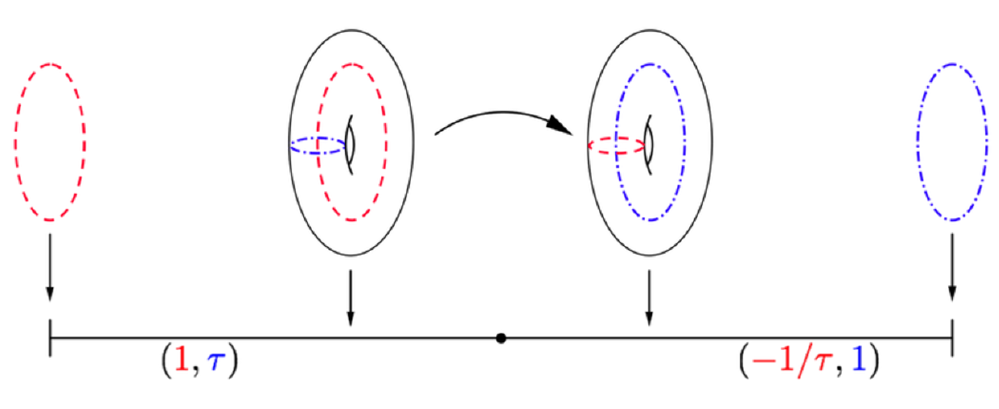
Figure 2 . Squashed S 3 viewed as a torus (cid:12)bered over the interval. At the ends of the interval one of the two circles degenerates. On the left half of the geometry, as one goes around the red (dashed) circle, the second circle is twisted by 2 (cid:25)i(cid:28) . In gluing the left and right halves, one must interchange the two circles of T 2 . On the right half, in going around the blue circle the red circle gets twisted by (cid:0) 2 (cid:25)i=(cid:28)